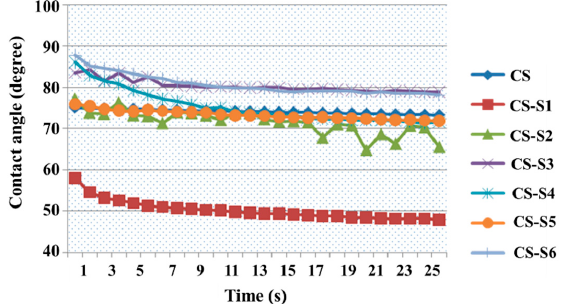
Figure 3. Water contact angle measurements for chitosan-derivative films.